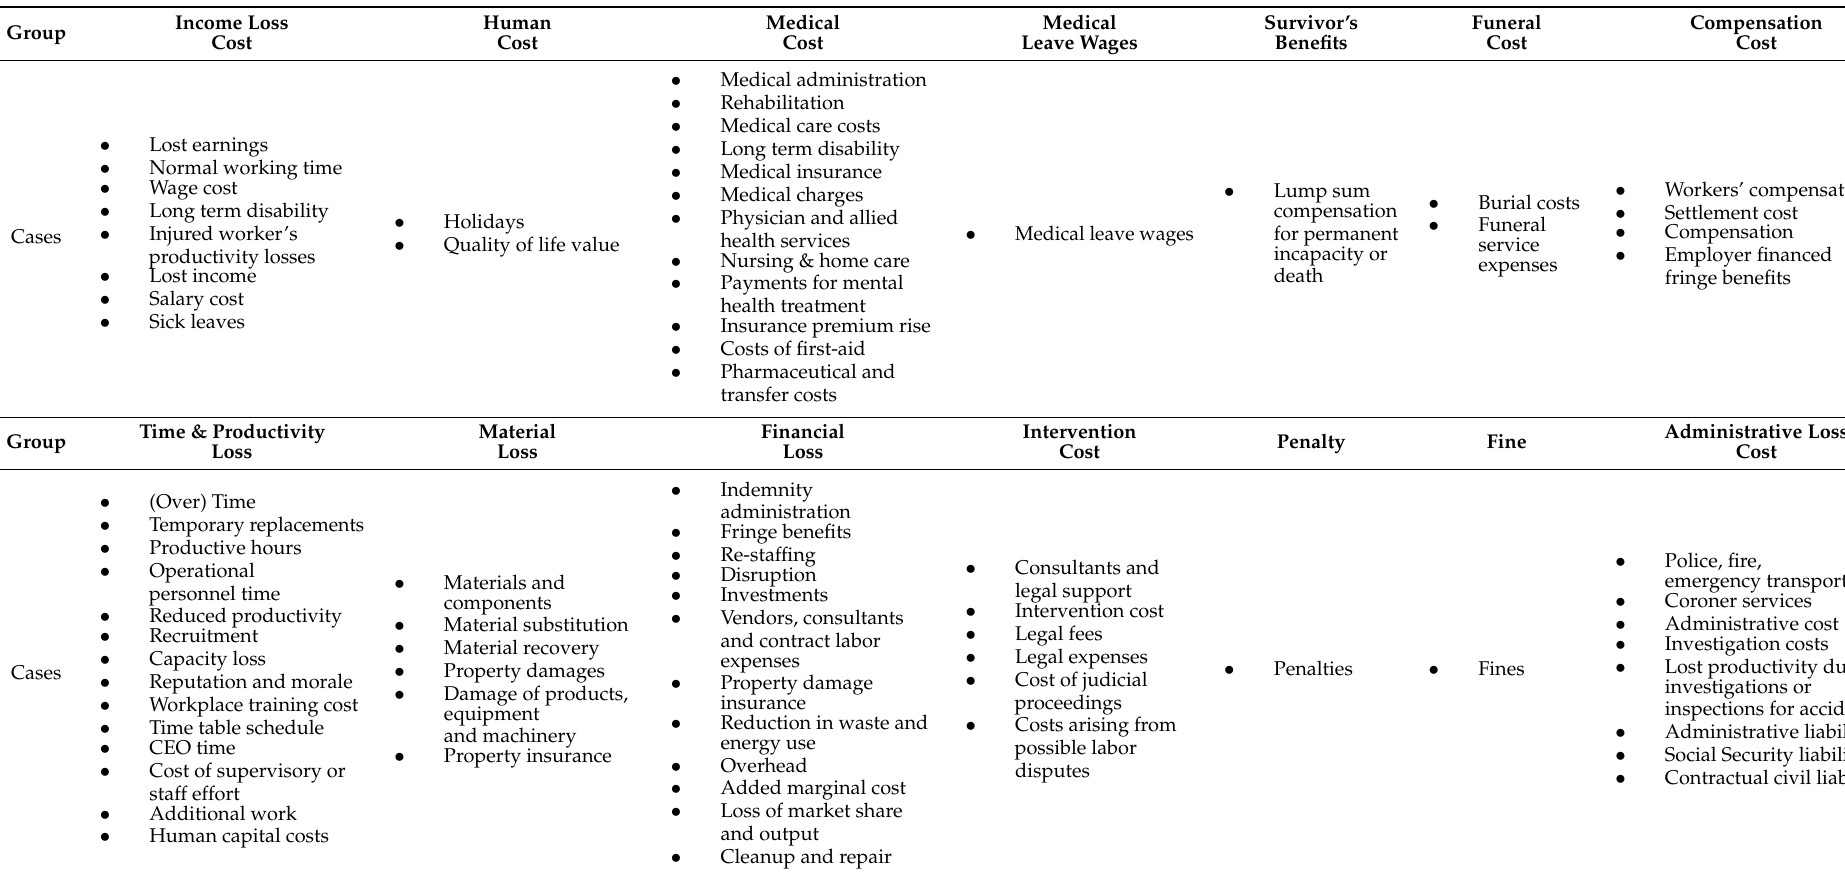
Table 4. Intermediate groups for cost cases extracted from previous